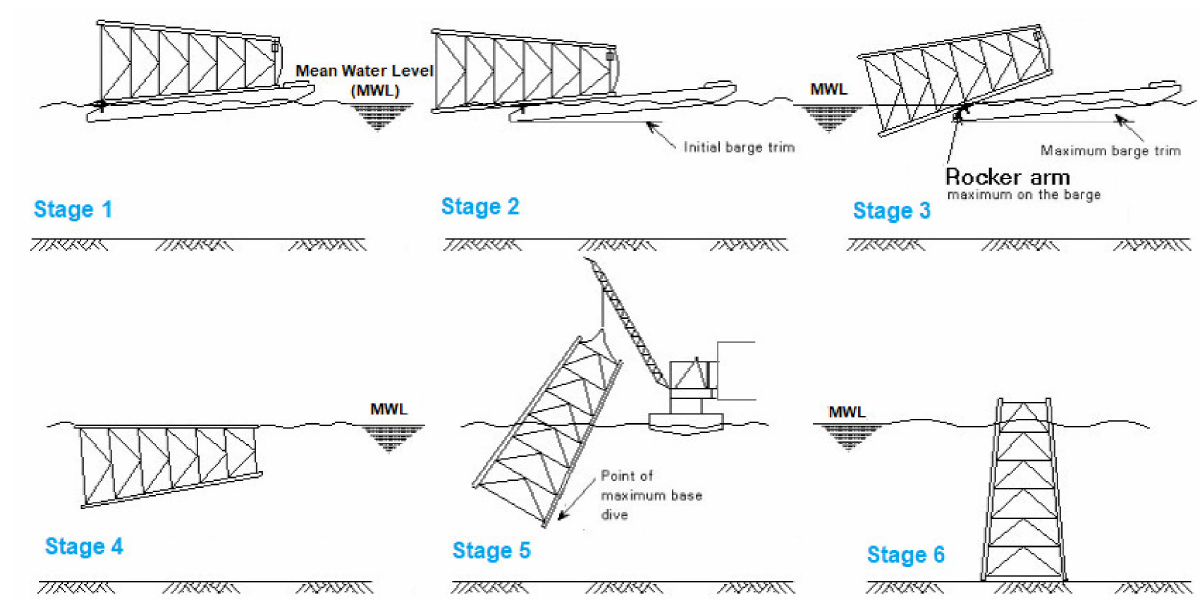
Figure 11. Launching and Upending sequences of a platform jacket.